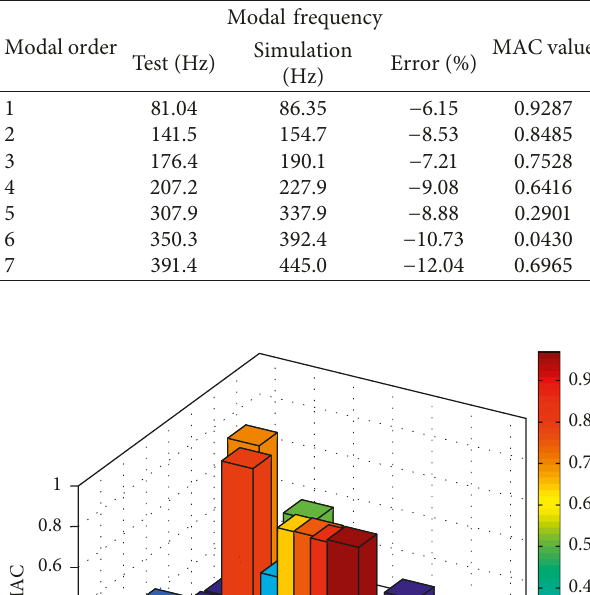
Figure 6: Mode shapes of the test. (a) First mode shape. (b) Second mode shape. Table 2: Calculation results of model correlation.